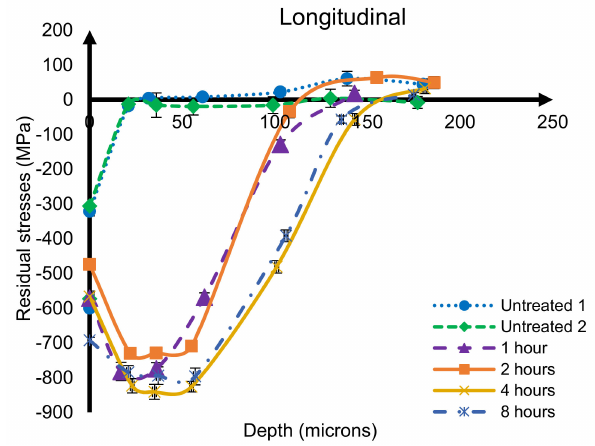
Figure 10. Residual stress profile of IN718 at − 130 mm in the longitudinal direction.